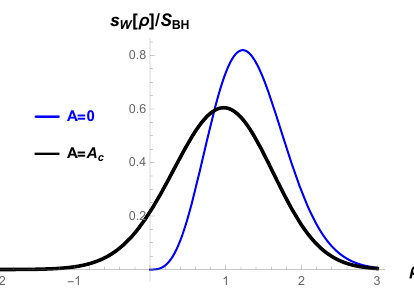
Figure 5 . Shown is the ratio of the entropy density of the winding-mode condensate to the black hole entropy for the critical solution (thick, black), and for a solution neglecting the backreaction (thin,